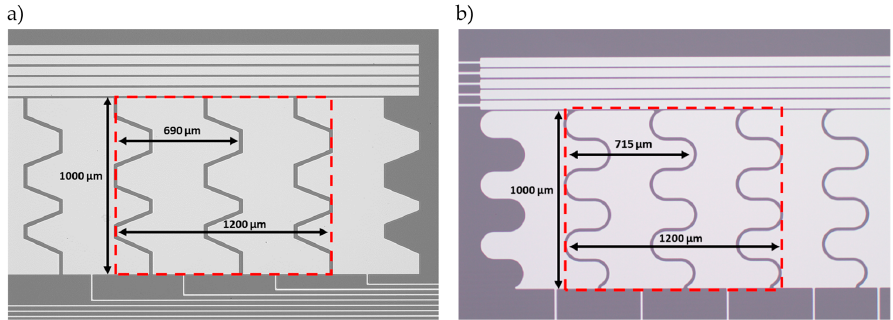
Figure 13. Size and dimensions of ( a ) trapezoidal shaped electrodes and ( b ) sine shaped electrodes. The fi ve fi nger electrodes on the side of the structure are not relevant for the long stroke actuation. The electrodes were realized using lithographically structured aluminum on silicon, with a 2 µm thermal SiO 2 layer to insulate the electrodes. The dielectric layer consisted of 110 nm Al 2 O 3 , deposited using atomic layer deposition (ALD). To achieve a reliable hy- drophobic surface with a contact angle >90°, a 1% fl uoropolymer solution (FluoroPel PFC1601V-FS) was applied by means of spin coating (Figure 14). The moving platform was a 220 µm thick silicon chip, likewise coated with fl uoro- polymer. The hydrophobic coating was locally removed from the contact areas where the droplets were to be a tt ached as bearings. Figure 14. Schematic structure of the actuator system. 3.2. System Modelling For an approximated model describing the dynamic behavior of the long-stroke ac- tuator for precise motion control, the system is decomposed into the four droplet bearings suspending the actuator platform. The elastic behavior of the droplets is represented by the spring constant c . A single droplet can be described using the mechanical analogy de- picted in Figure 15. The platform mass 𝑚 T was connected to the bo tt om mass 𝑚 B , corresponding to the droplet mass, by a linear spring with the sti ff ness 𝑐 . In combination with the quadratic air friction force 𝐹 A , this enabled the emulation of the droplets ringing behavior. The air fric- tion within the model is given as follows: 𝐹 A = sign(cid:4666)𝜌(cid:4662)(cid:4667)𝑑 T 𝜌 (cid:2870) (cid:4662) (16) where 𝜌(cid:4662) denotes the velocity of the top mass and 𝑑 T denotes the friction coe ffi cient. The combination of the nonlinear friction force 𝐹 S and the linear friction force 𝐹 V re fl ects the interaction at the interface between droplet and chip. This allowed us to incorporate the